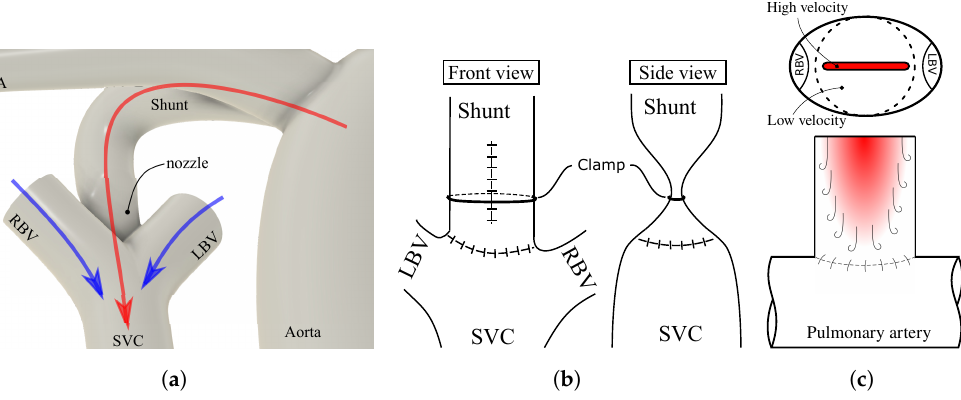
Figure 1. ( a ) Closeup of the insertion location of the shunt in the modified ABG. ( b ) Front and side view of potential clinical implementation of the slit-shaped nozzle design. LBV and RBV are removed from the side view. ( c ) nozzle view from the SVC and mixing visualization. BA, brachiocephalic artery; SVC, superior vena cava; LBV, left brachiocephalic vein; RBV, right brachiocephalic